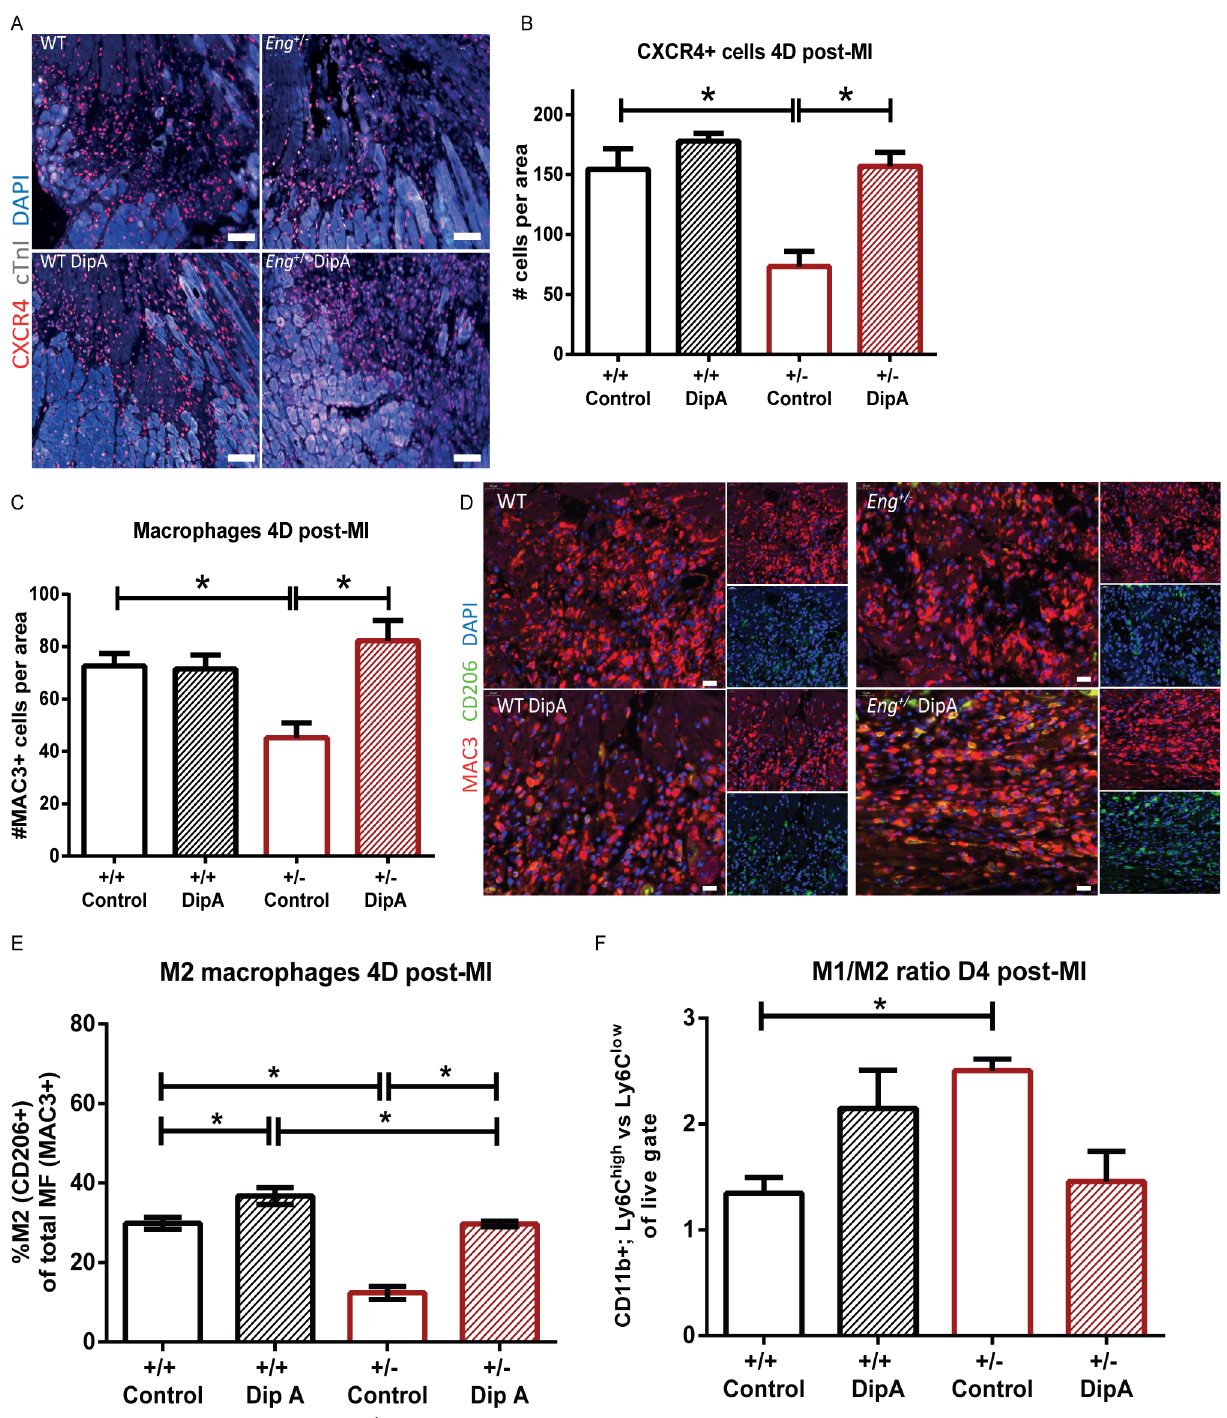
Fig 2. DPP4 inhibitor treatment of Eng +/- mice restores homing of MNCs to injured myocardium at 4 days post-MI. (A) Representative microscopy images of CXCR4 expressionin the infarct border zone. White = survivingmyocardium, black/greyarea = infarcted myocardium. Photos taken at 30x magnification. Scale bar: 50 μ m.CXCR4 = red, cTnI = white, DAPI nuclear staining= blue. (B) Quantificationof CXCR4 expressingcells in the infarct border zone (n = 6–8). Data shown are mean ± SEM, * P < 0.05. (C) Quantification of MAC3 positive cells in the infarct border zone (n = 6–7). Data shown are mean ± SEM, * P < 0.05. (D) Representative microscopyimages of MAC3 + /CD206 - (%M1) and MAC3 + /CD206 + (%M2) expressing cells in the infarct border zone. Smaller panels:Top panel is the MAC3 signal, lower panel is the CD206 signal. Photos taken at 50x magnification. Scale bar: 20 μ mMAC3 = red, CD206 = green, DAPI = blue. (E) Quantificationof the ratio of